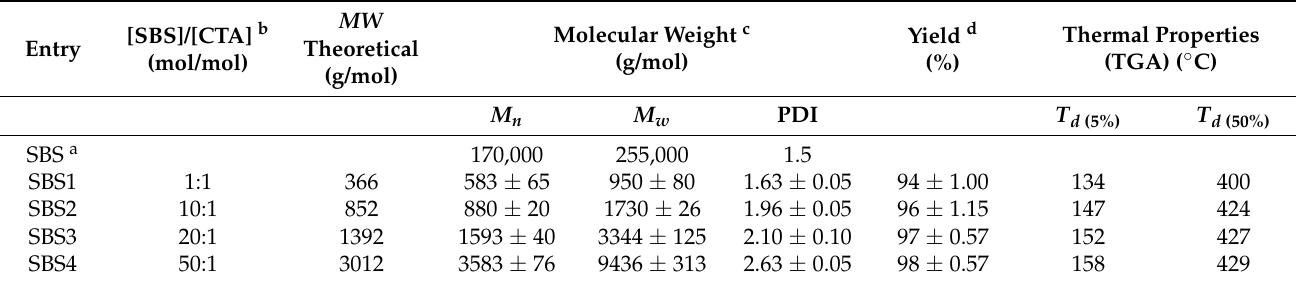
Table 1. Synthesis of biobased HTPB via metathesis degradation from SBS using 10-undecen-1-ol as